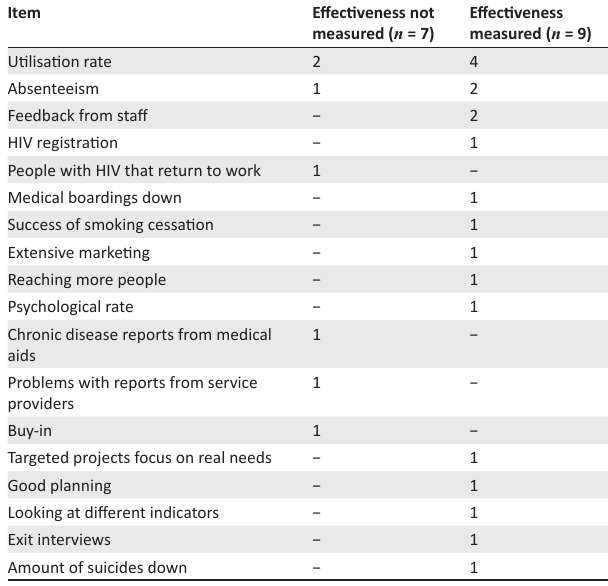
TABLE 7: How organisations measure the effectiveness of programmes.